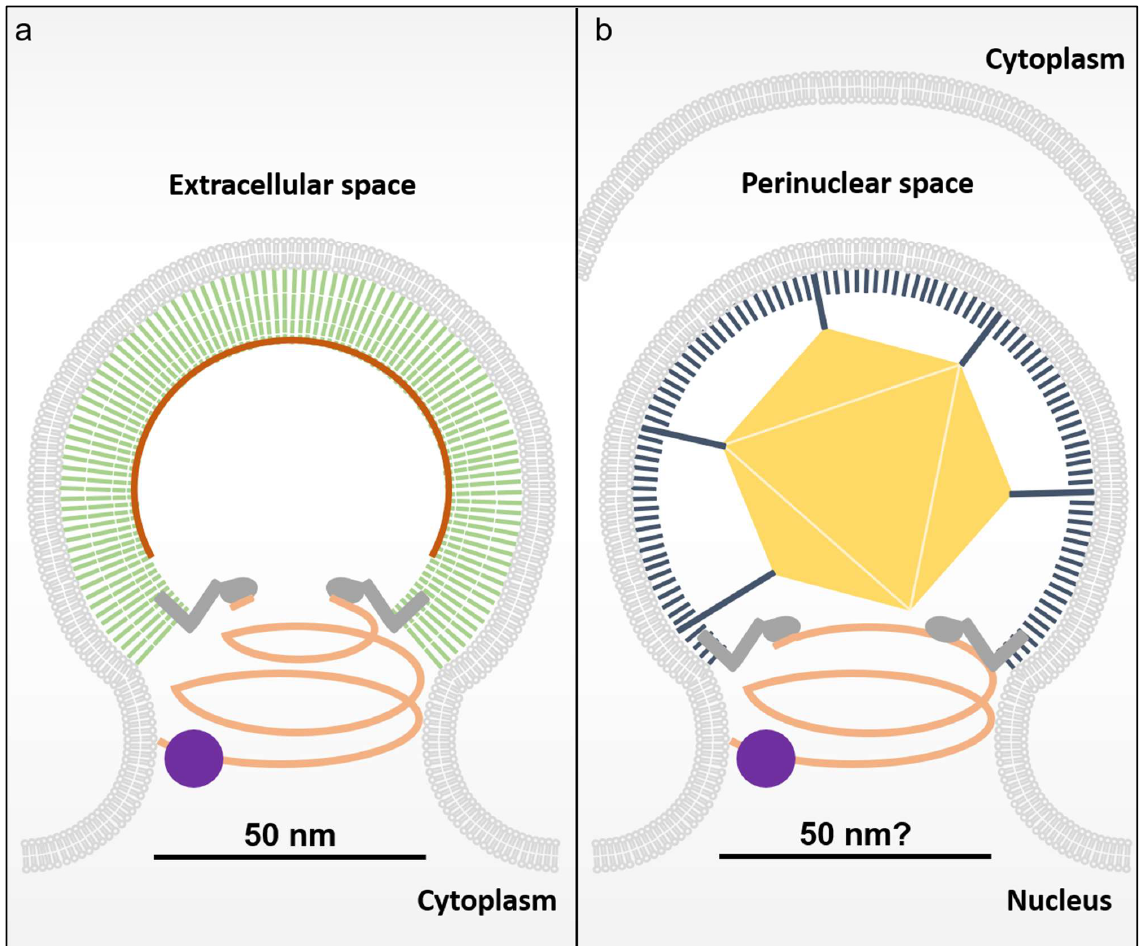
Figure 2. The process of HSV-1 nuclear egress and scission resembles the retroviral egress pathway. ( a ) Diagram of the well characterized HIV-1 budding site. HIV-1 Gag (green sticks) binds RNA (dark orange) and assembles on the membrane and recruits ALIX (dark grey) via the L-Domain located in its C-terminal p6 domain. HIV-1 budding necks have been shown typically to adopt a diameter of approximately 50 nm prior to membrane scission and this topology is likely to be shared by the NEC given the mechanistic constraints of the ESCRT-III membrane scission machinery. The downstream ESCRT-III is shown in salmon and the VPS4 membrane scission machinery in purple. ( b ) HSV-1 particle assembly begins in the nucleus where a newly formed capsid must transit the nuclear envelope by assembly and budding. Schematic of the HSV-1 nuclear egress complex prior to membrane scission assembled with its capsid as it buds through the nuclear envelope. A single virus capsid is shown as a gold hexagon and the NEC UL31-UL34 heterodimer is shown as membrane-associated sticks (black) that occasionally interact with the vertices of the capsid. ALIX is recruited to sites of nuclear egress through interactions with NEC and mediates the recruitment of the downstream ESCRT components to facilitate membrane scission.